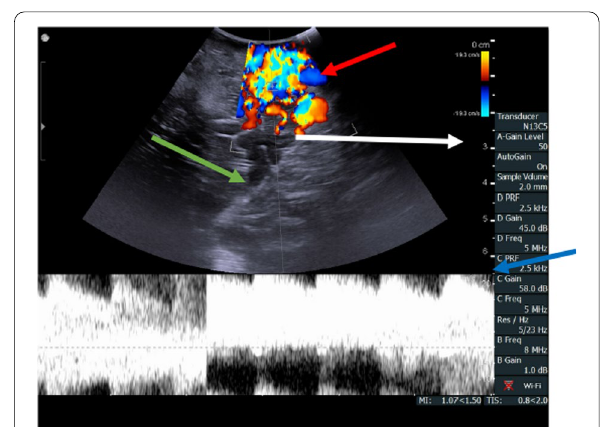
Fig. 5 IOUS of AVM Case. Color Doppler image showing bidirectional, high‑blood flow within the tubular structures, suggestive of blood flow within an AVM (red arrow). It also gives an idea about the depth of resection needed (here up to 3 cm depth) (white arrow). Color Doppler and its relation to the adjacent dural folds (tentorium cerebelli) (green arrow). High pattern of flow in the nidus which exceeds 25 m/s detected by spectral Doppler US (blue